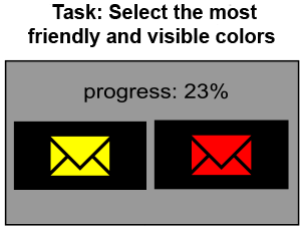
Figure 2. Overview of the forced-choice procedure used in the experiment. The task given to the observer was to select the most friendly and visible